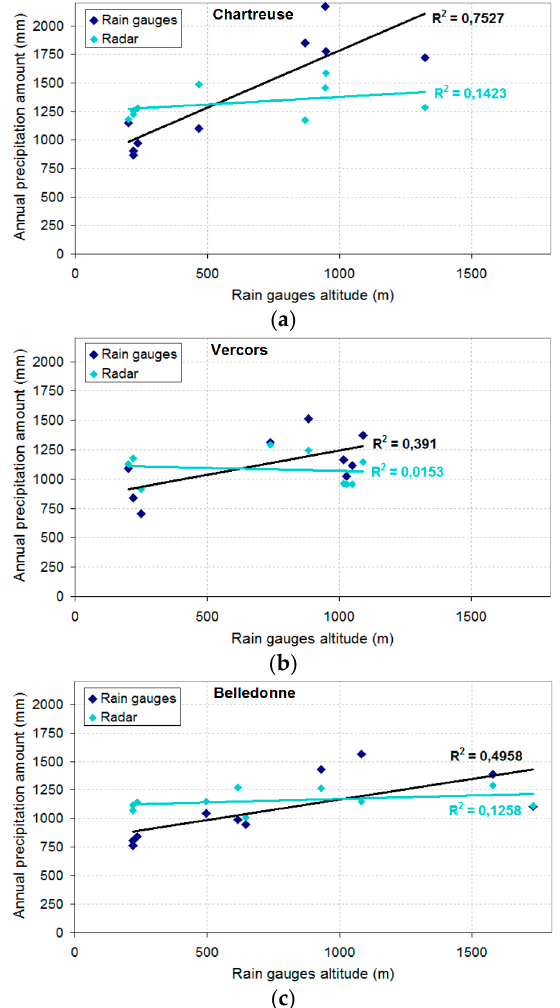
Figure 4. Comparison of rain gauge annual accumulations and the corresponding radar QPEs in 2016 as a function of rain gauge altitudes, for a subset of nine rain gauges for Chartreuse and Vercors, and ten rain gauges for